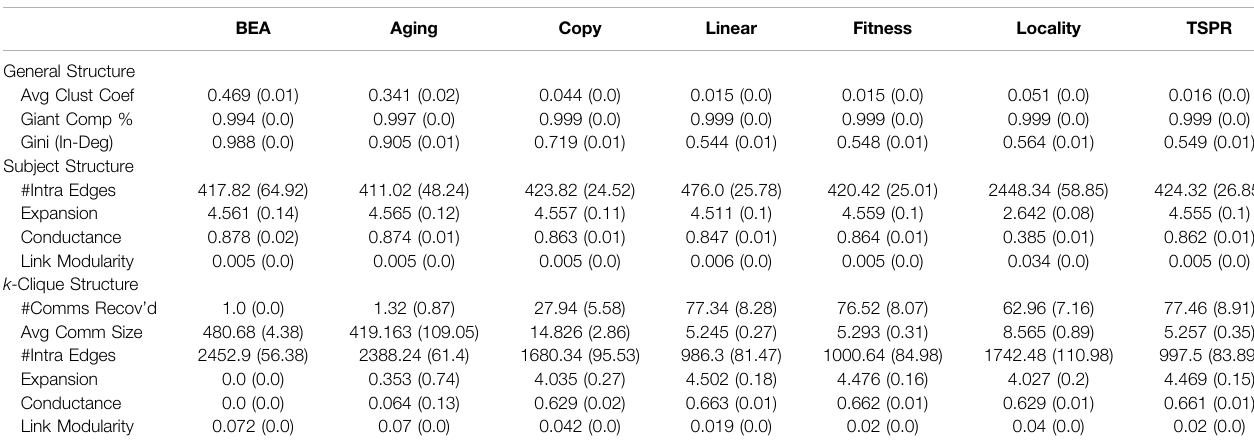
TABLE 2 | Simulated properties for softmax-normalized and copying models. BEA Aging Copy Linear